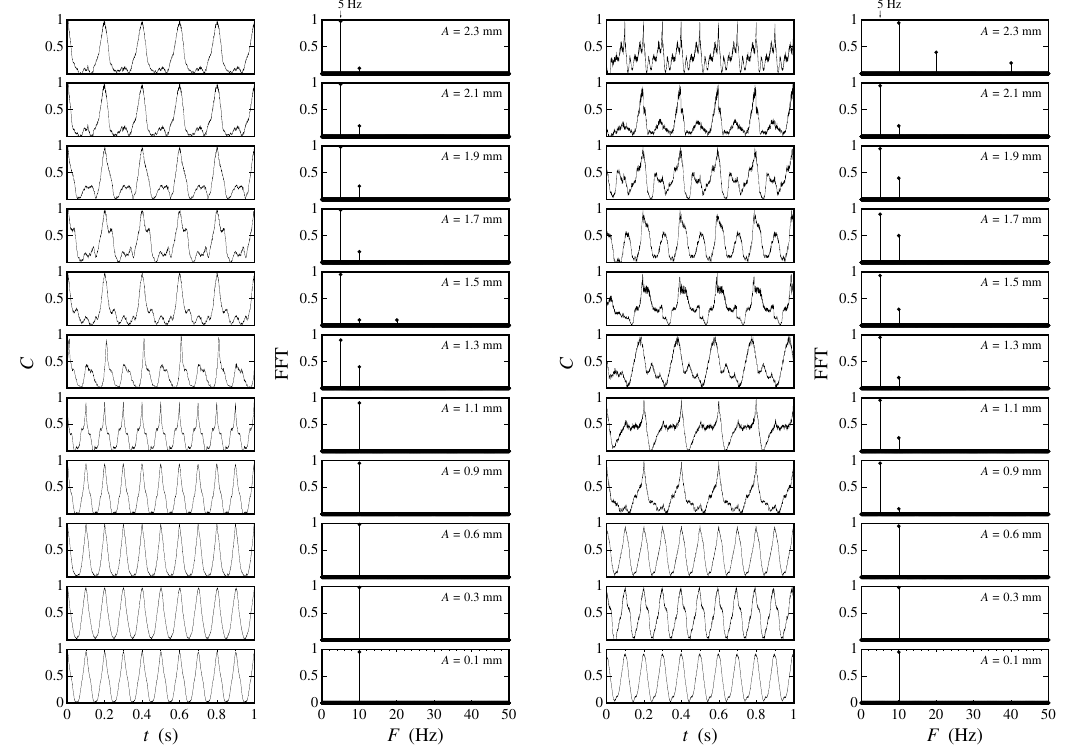
Figure 6. Pearson correlation coefficients as a function of time and corresponding frequency spectrum for F = 10 Hz and varying amplitudes from 0.1 mm to 2.3 mm. The two columns of plots on the left are for the small ( l = 2.5 cm) cells, while the two columns of plots on the right are for the larger ( l = 5 cm)